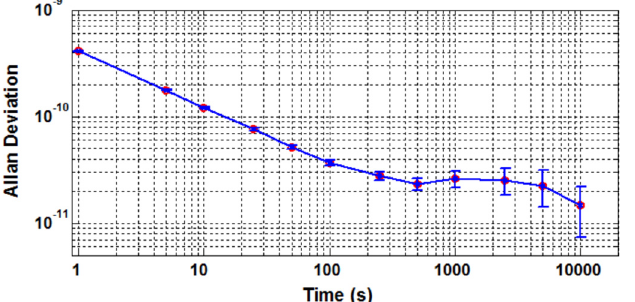
Fig. 6. f beat deviation of HP5517D laser against frequency comb.